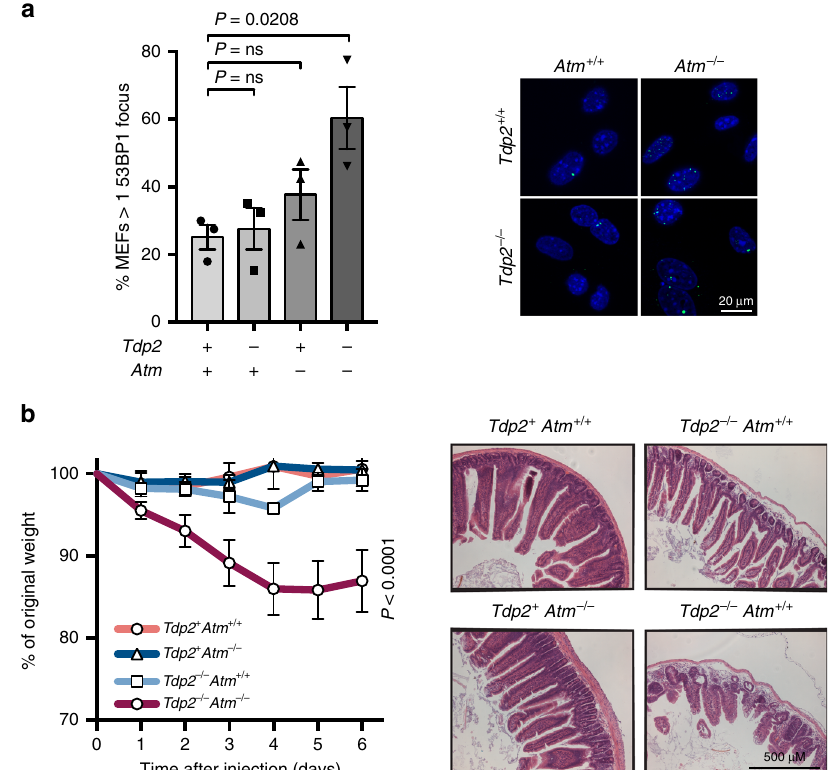
Fig. 1 Tdp2 − / − Atm − / − causes the spontaneous accumulation of DSBs and etoposide hypersensitivity in mice. a Endogenous DSB occurrence in Tdp2 + / + Atm + / + , Tdp2 − / − Atm + / + , Tdp2 + / + Atm − / − and Tdp2 − / − Atm − / − primary MEFs measured by 53BP1 foci formation. The percentage of cells with more than one focus (left) and representative images (right) of 53BP1 foci (green) and DAPI staining (blue) are shown for each genotype. MEFs isolated from three different embryos were analysed per condition. Mean± SEM and statistical signi fi cance by one-way ANOVA with Bonferroni post-test is shown ( F = 5,402). b Body weight of 8-week old mice cohorts intraperitoneally injected with a single dose of etoposide (25 mg/kg). Average ± SEM of the percentage of initial body weight from fi ve mice and statistical signi fi cance by Two-way ANOVA with Bonferroni post-test is shown ( F = 29,11). Tdp2 + indicates both Tdp2 + / + and Tdp2 + / − genotypes. Representative images of Haematoxylin-Eosin stained jejunum slices obtained 6 days after etoposide exposure are